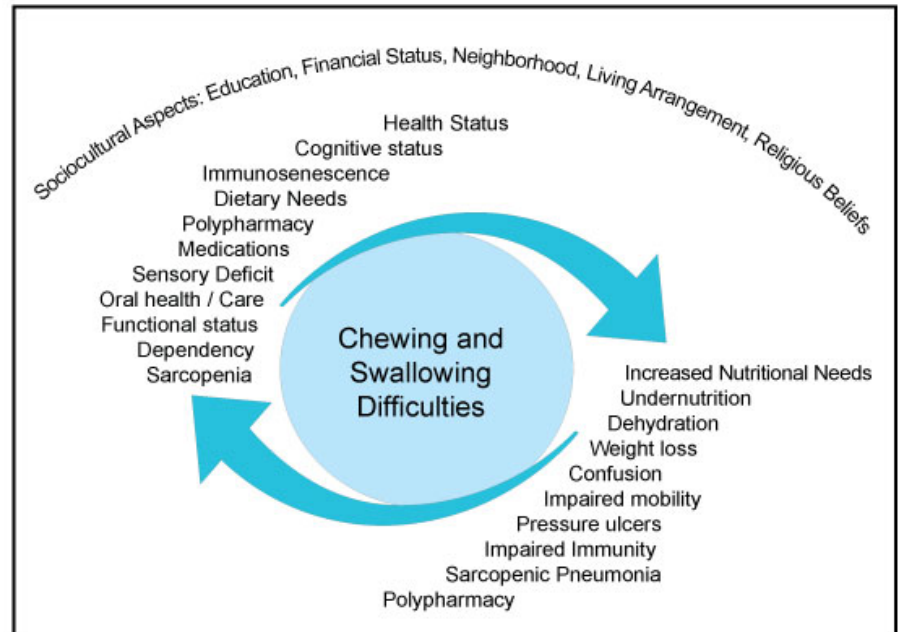
Figure 1. Interaction model of key factors a ff ecting feeding in the context of dysphagia in the older adult population.